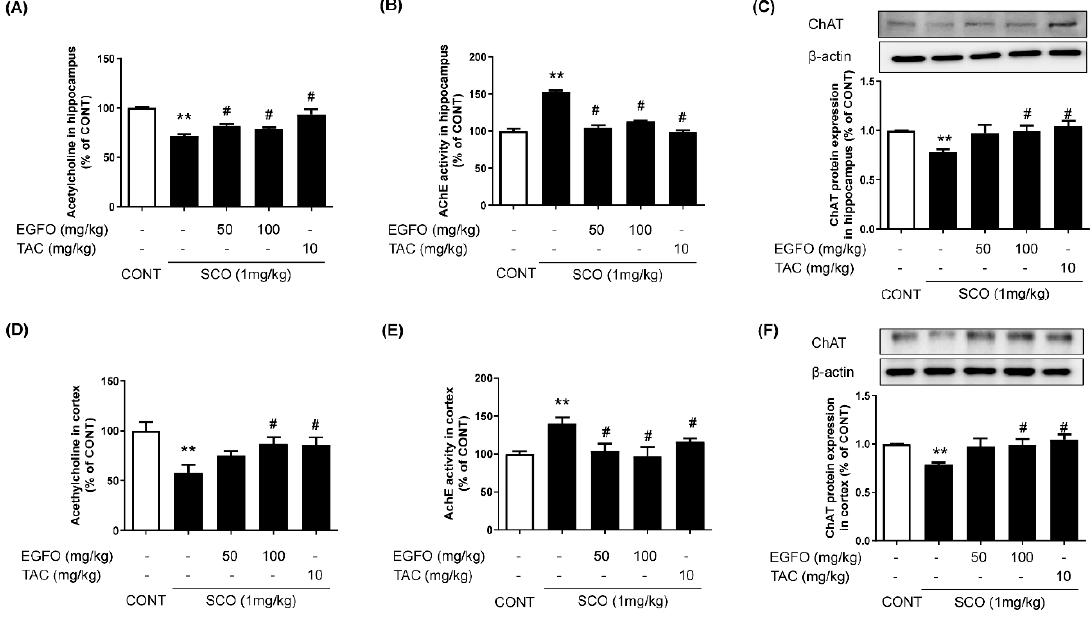
Figure 3. Effect of EGFO extract on cholinergic dysfunction in mice with scopolamine-induced memory impairments . Ach levels ( A and D ) and AChE activity ( B and E ) in the hippocampus ( A and B ) and cortex ( D and E ) were measured using respective assay kits (US Biomax Inc., Denwood, MD, USA). ( C and F ) Hippocampal and cortical tissues were lysed and subjected to Western blotting using an anti-ChAT antibody. Levels of expression were normalized by β -actin. Bar graphs represent the relative intensity in each band. Values are expressed as the mean ± SEM. ( n = 7/group). ** p < 0.01 vs CONT group, # p < 0.01 vs. SCO group. Ach: Acetylcholine; AChE: Acetylcholinesterase; ChAT: